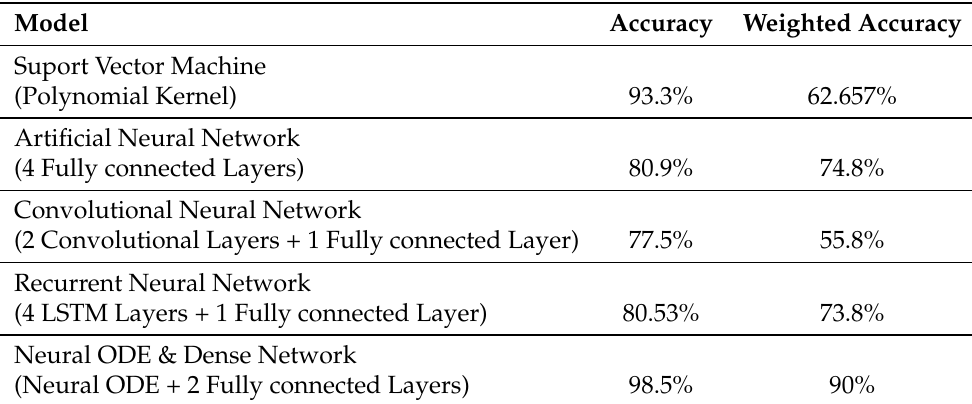
Table 2. Accuracy for different Machine learning